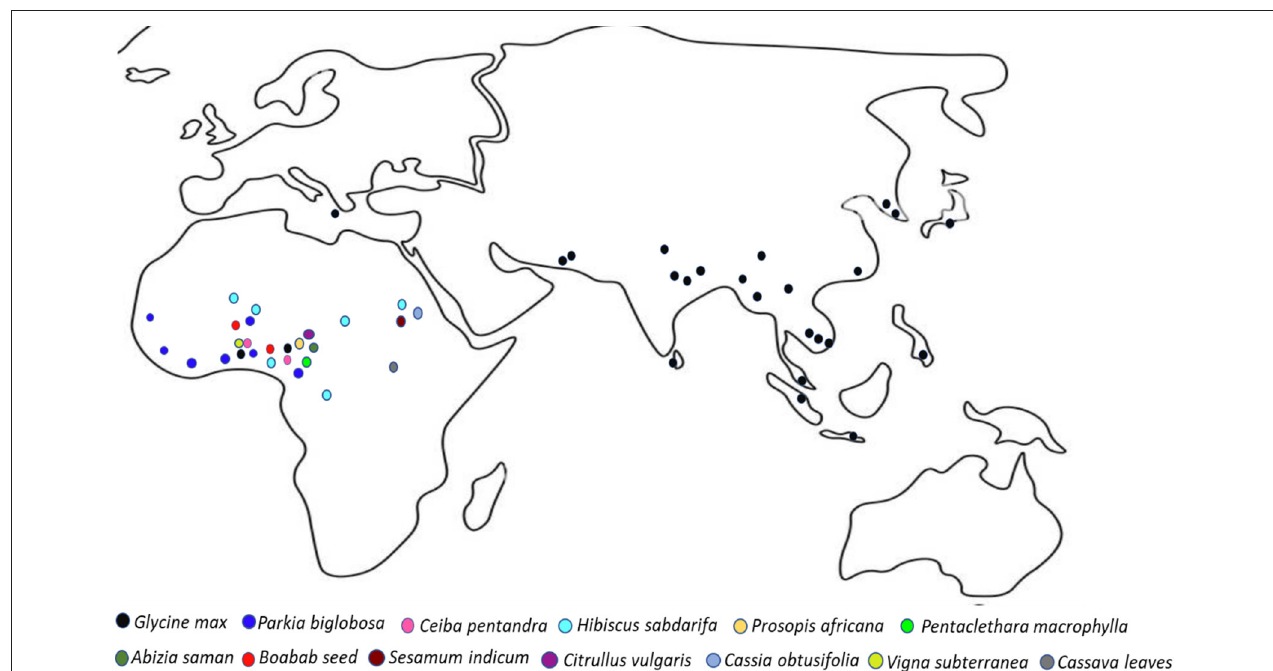
FIGURE 2 | Diversity and distribution of plant species used for the production of alkaline fermented foods in Africa and